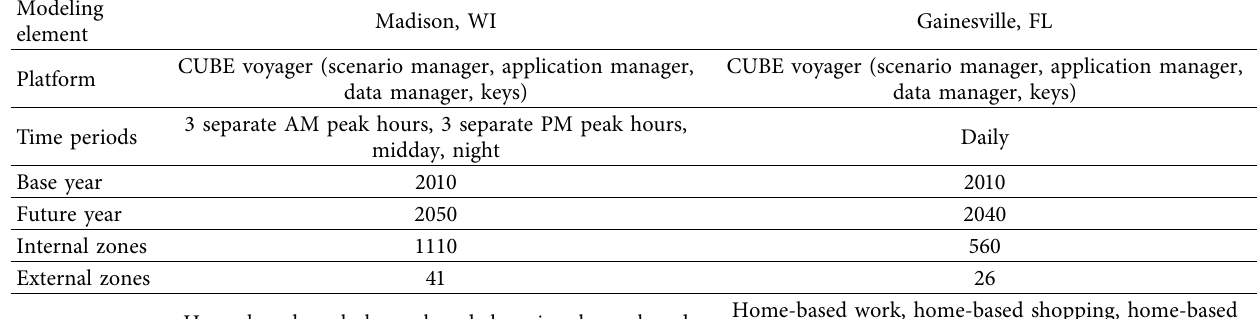
Table 1: Travel model subelement